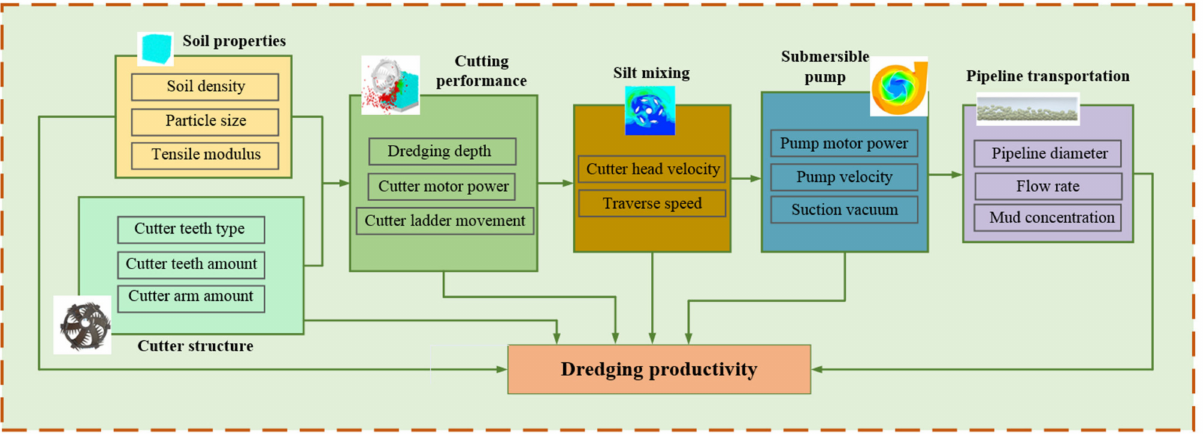
Figure 4. The monitoring parameters related to dredging process and productivity.